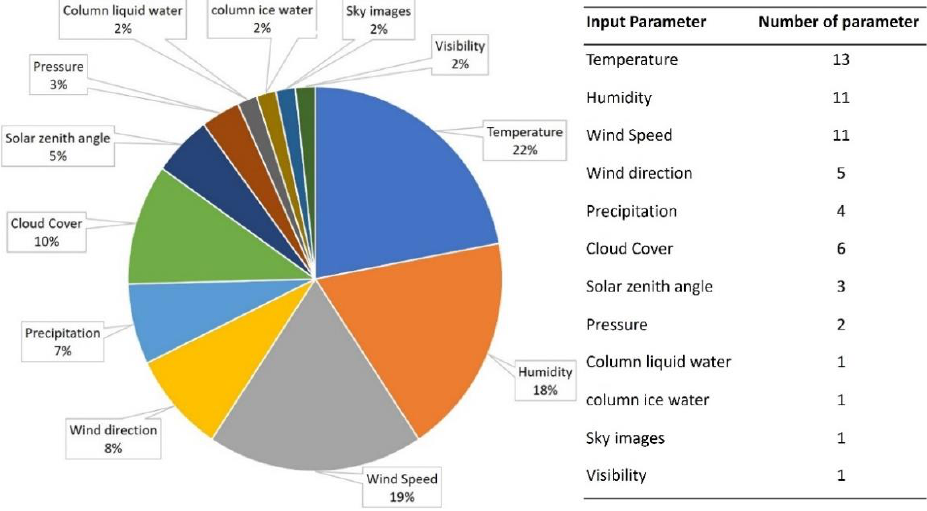
Figure 12. Percentage of the input parameters used to predict solar irradiance and PV power.